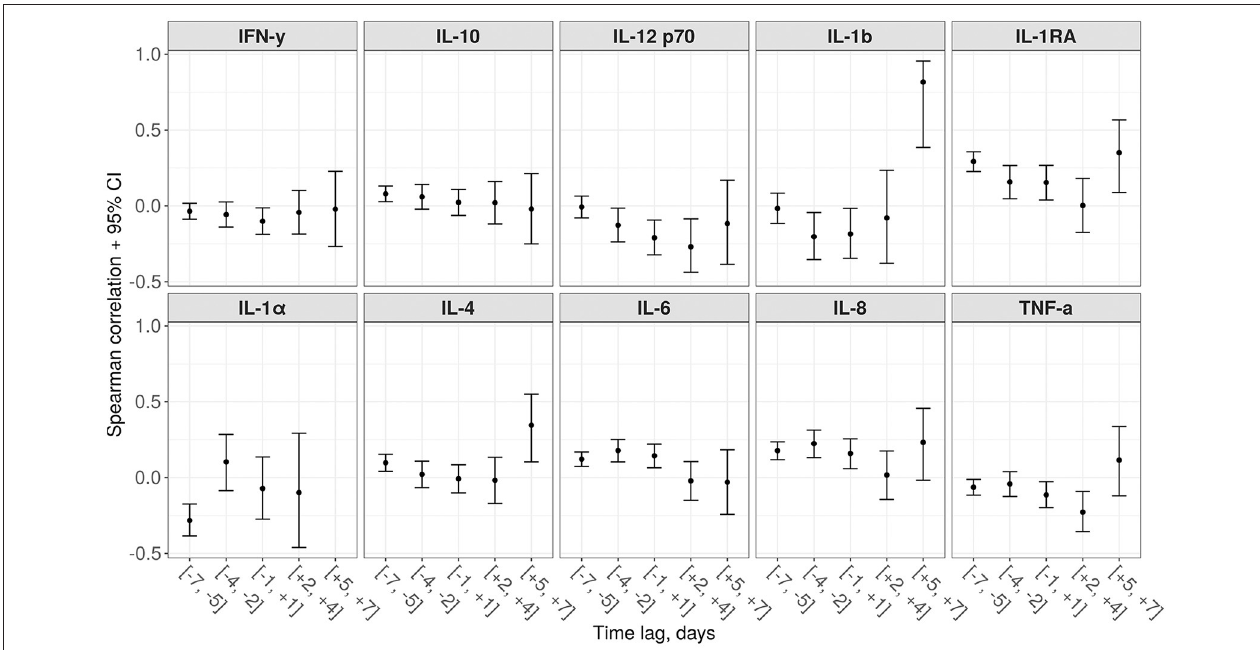
FIGURE 7 | Spearman correlations between the proposed score and 10 various cytokines for different time lags (a negative lag represents cytokine testing preceding the score calculation, while a positive lag—on a contrary, succeeding).